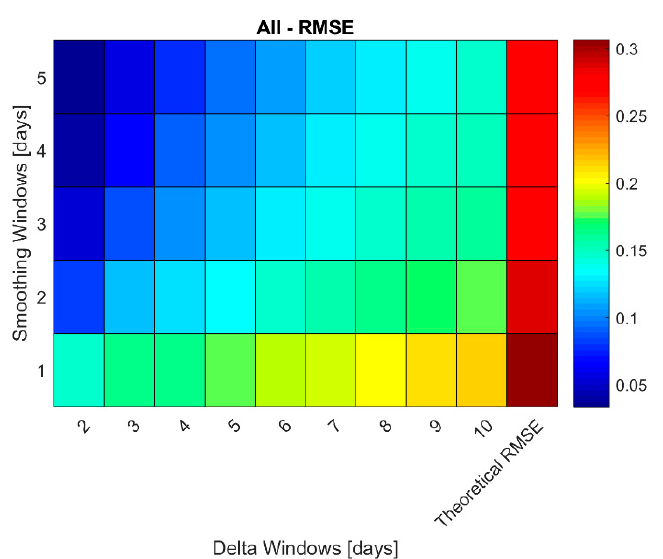
Figure 9. Actual versus theoretical RMSE performance of the Δ LUE Canopy retrievals at all sites at different levels of smoothing and values of Δ . N = 5071.